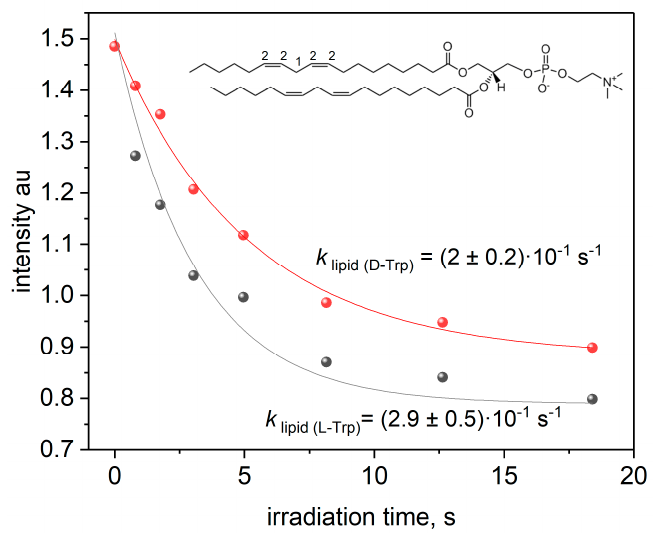
Figure 9. Decay kinetics of 1 H NMR signals lipid protons (1) at 2.7 ppm on irradiation time in DHPC/DLPC bicelles at pH = 3.3.